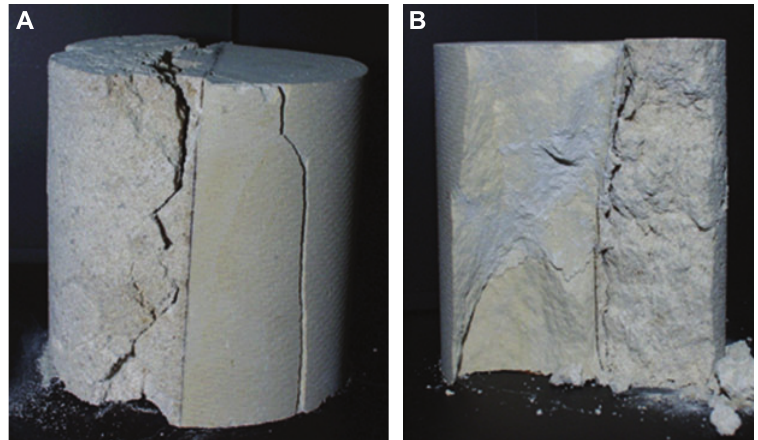
Figure 13 Cylindrical composite specimens subjected to compression (with rotatable loading platens) made from two equal halves with vertical joining plane.